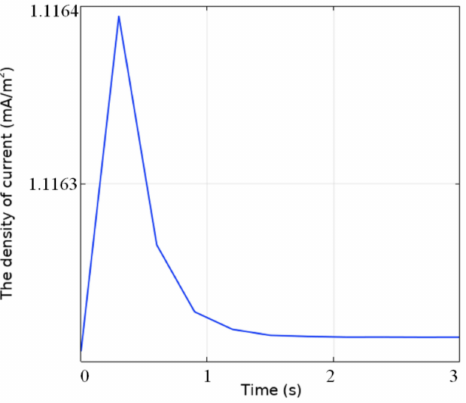
Figure 6. The change of current density with time when the electric field intensity is 150 V/cm. Through the simulation, it is found that when the magnitude of the electric field inten- sity is changed, the displacement of the sample surface remains unchanged, as shown in Figure 7. It shows that the electric field intensity will not affect the grain size of the sample. Liu Guangxin [35] took 8YSZ ceramics as the research object. The current through the sample was set to 0.05 A, and the electric field intensity was set to 190 V/cm, 255 V/cm and 325 V/cm, respectively. The curve of the current density changing with the flash sintering time was obtained. The curve of current density is consistent with the curve in this paper, and both of them have a sudden change. The results show that the electric field intensity does not change the density, and the electric field intensity determines the incubation time. This is consistent with the simulation results in this